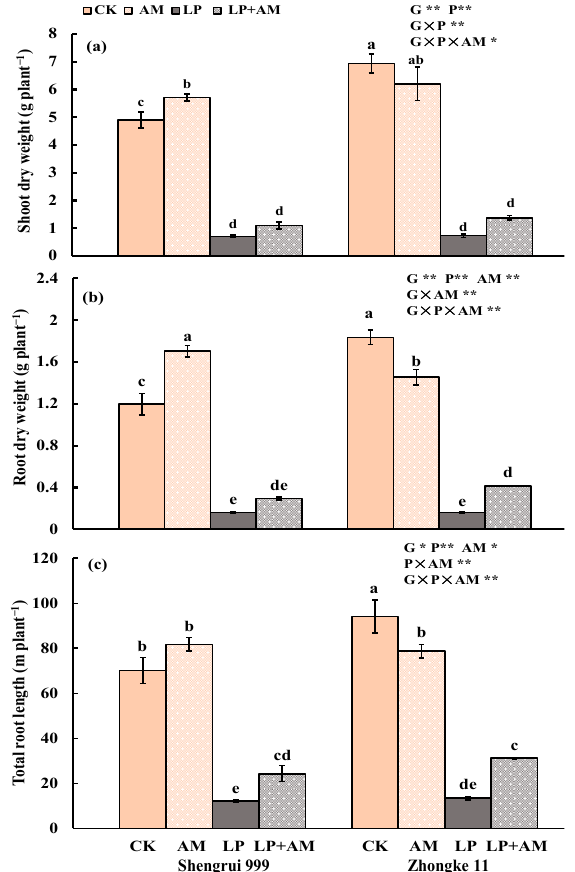
Figure 1. Shoot dry weight (g plant − 1 ) ( a ), root dry weight (g plant − 1 ) ( b ), and the total root length (m plant − 1 ) ( c ) of two maize genotypes (Shengrui 999 and Zhongke 11) under four treatments. Note: CK (optimal P, 200 mg kg − 1 ), AM (optimal P + arbuscular mycorrhizal fungal inoculation), LP (low P, no added P), and LP + AM (low P + arbuscular mycorrhizal inoculation). For each trait, bars with